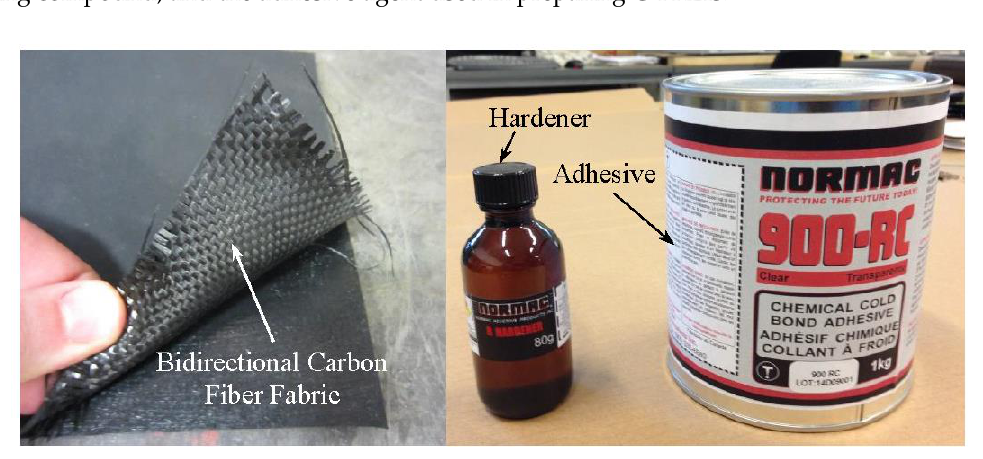
Figure 2. Reinforcement and cold bonding compound used in C-FREIs.